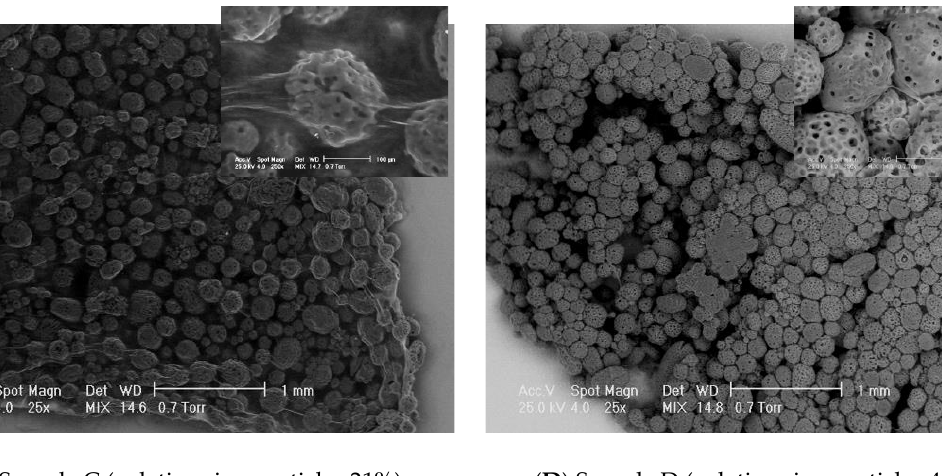
Figure 7. SEM results on the experimental samples collagen based loaded with gelatin